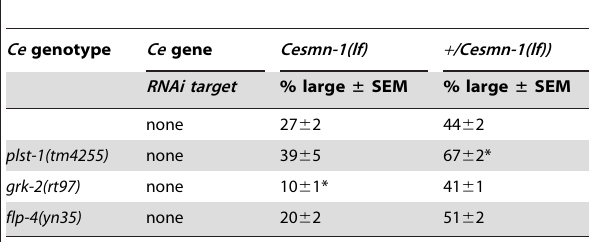
Table 2. C. elegans orthologs of PLS3, GRK, and FMRFamide modify Cesmn-1(lf) growth